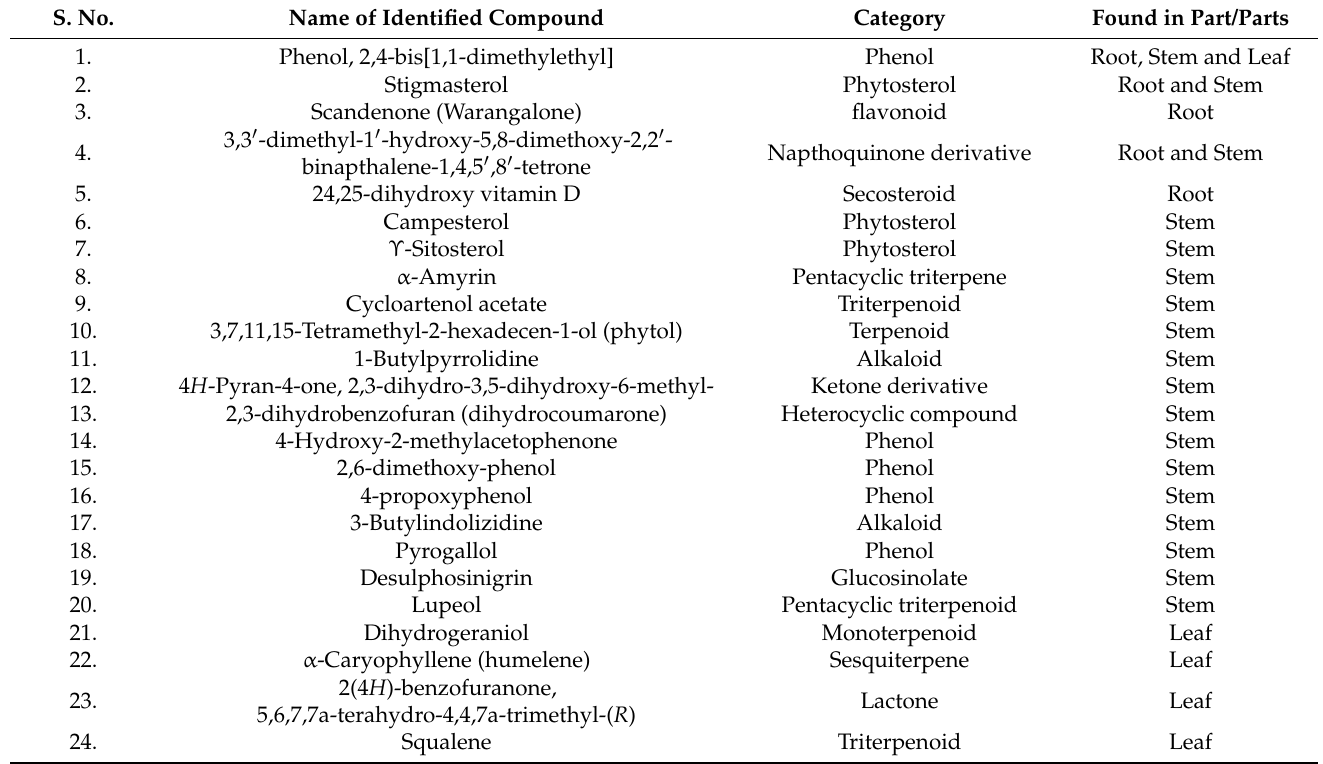
Table 7. Secondary metabolite profile of N. triquetra identified by